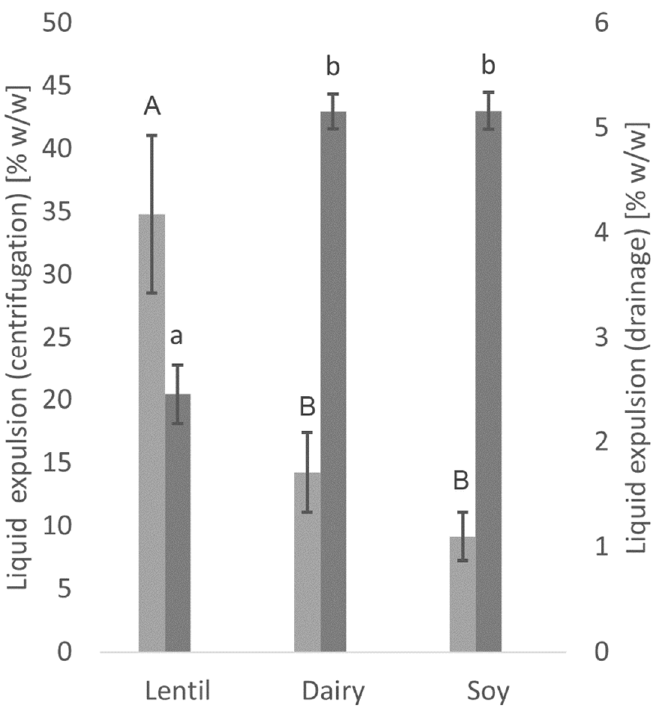
Figure 2. Liquid expulsion as measured with the centrifugation method (light grey) and drainage method (dark grey). Values with different superscript letters within columns for the centrifugation method (capital letters) or drainage method (lowercase letters) are significantly different ( p ≤ 0.05).